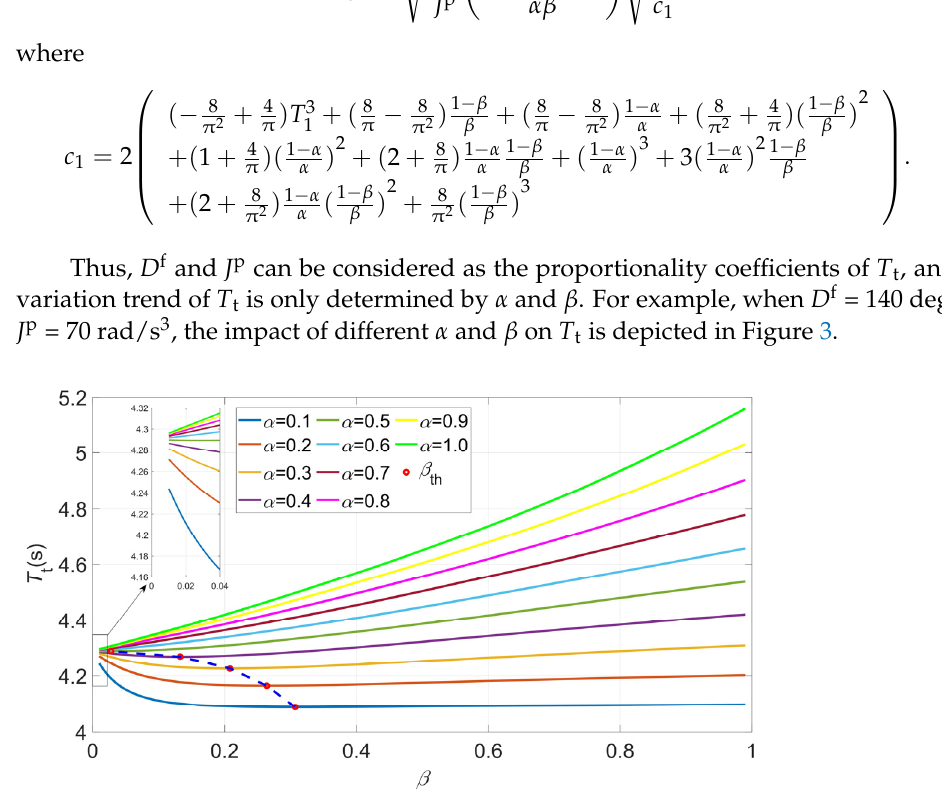
Figure 3. Impact on T t with different values of α and β .